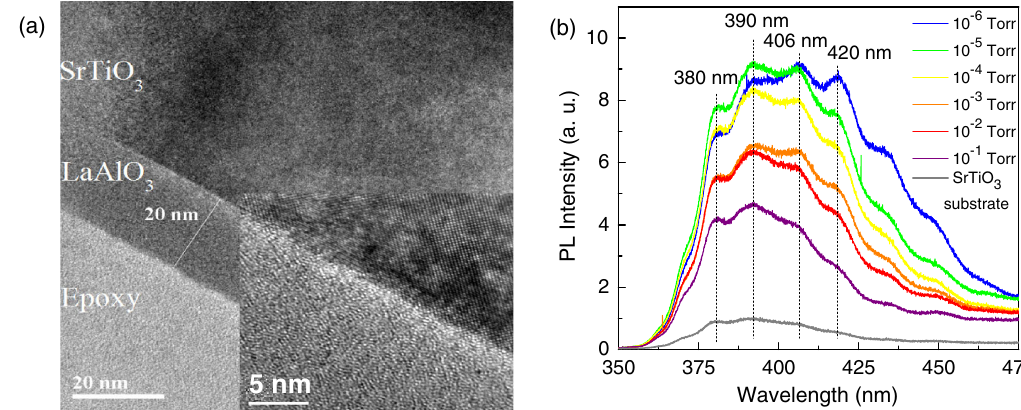
FIG. 1. Structural and optical properties of amorphous LaAlO 3 = SrTiO 3 (LAO/STO) heterostructures. (a) Transmission electron microscopy image of a LAO film deposited on an untreated STO substrate at room temperature and 10 (cid:2) 6 Torr oxygen pressure. Inset: Zoom-in image of an interface region. (b) Room-temperature PL spectra of an as-received STO substrate and 20-nm amorphous LAO films deposited on untreated STO substrates at different oxygen partial pressure ranging from 10 (cid:2) 1 to 10 (cid:2) 6 Torr